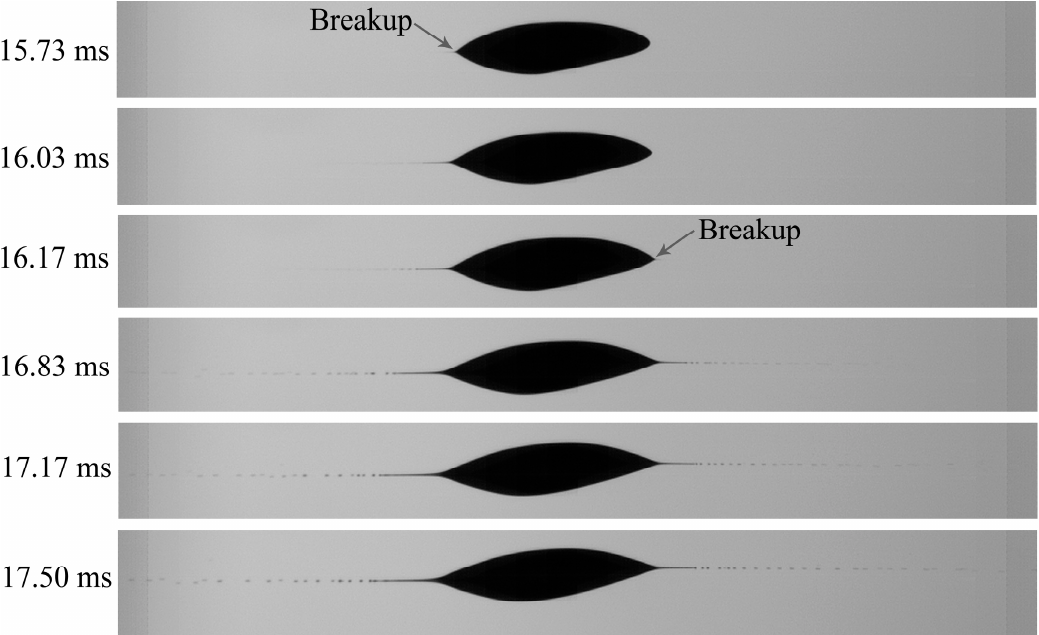
Figure 8. The secondary breakup of both sides of single electrified Al/n-decane nanofluid fuel droplet at the concentration of 8.0 mg/mL.